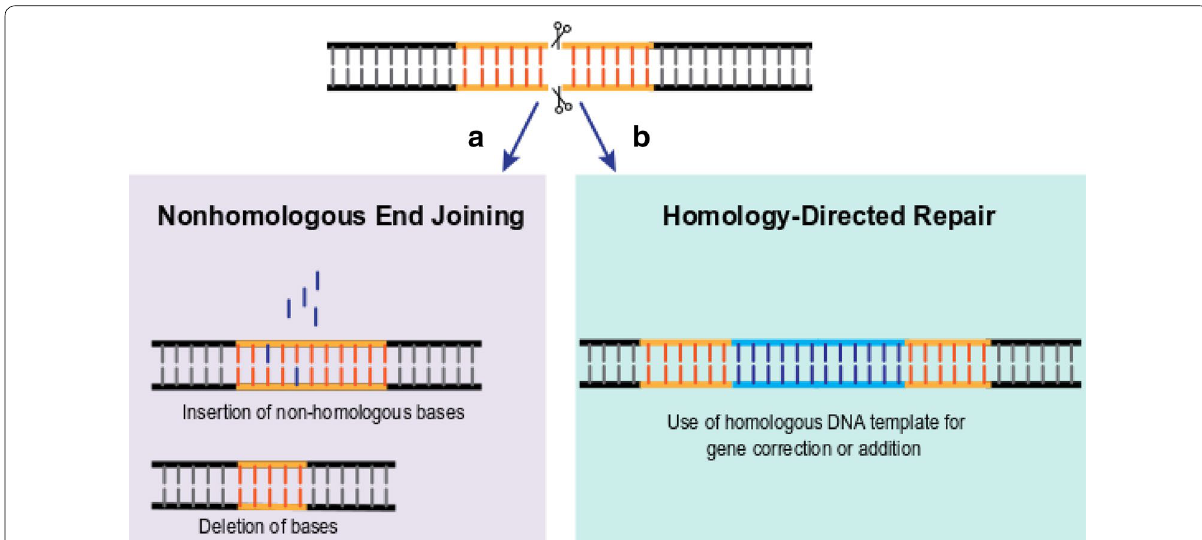
Fig. 2 Mechanisms of double strand break repair exploited for gene editing. a Illustration of the results of the error‑prone repair process during non‑homologous end joining (NHEJ), which can introduce a mutation at the site of the double strand break through either the incorporation of random non‑complementary nucleotides, or the deletion of nucleotides (indels). The goal is to either render a protein non‑functional (e.g. knockout of diseased protein or preferentially knockout a functional protein for therapeutic benefit) or to (re‑)activate a gene by either correcting/eliminating a deleterious nucleotide in the region of the break site or knocking out a repressive/inactivating element due to the introduction of an indel within that element. b Depiction of the results of homology‑directed repair. Here a double strand break is induced in the presence of donor DNA. The donor DNA has nucleotide sequences flanking the gene to be inserted that are homologous to those upstream and downstream of the site of the break, enabling addition of the gene based on complementarity during the repair